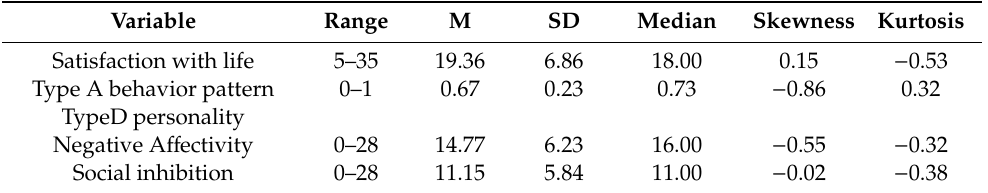
Table 1. Descriptive statistics.